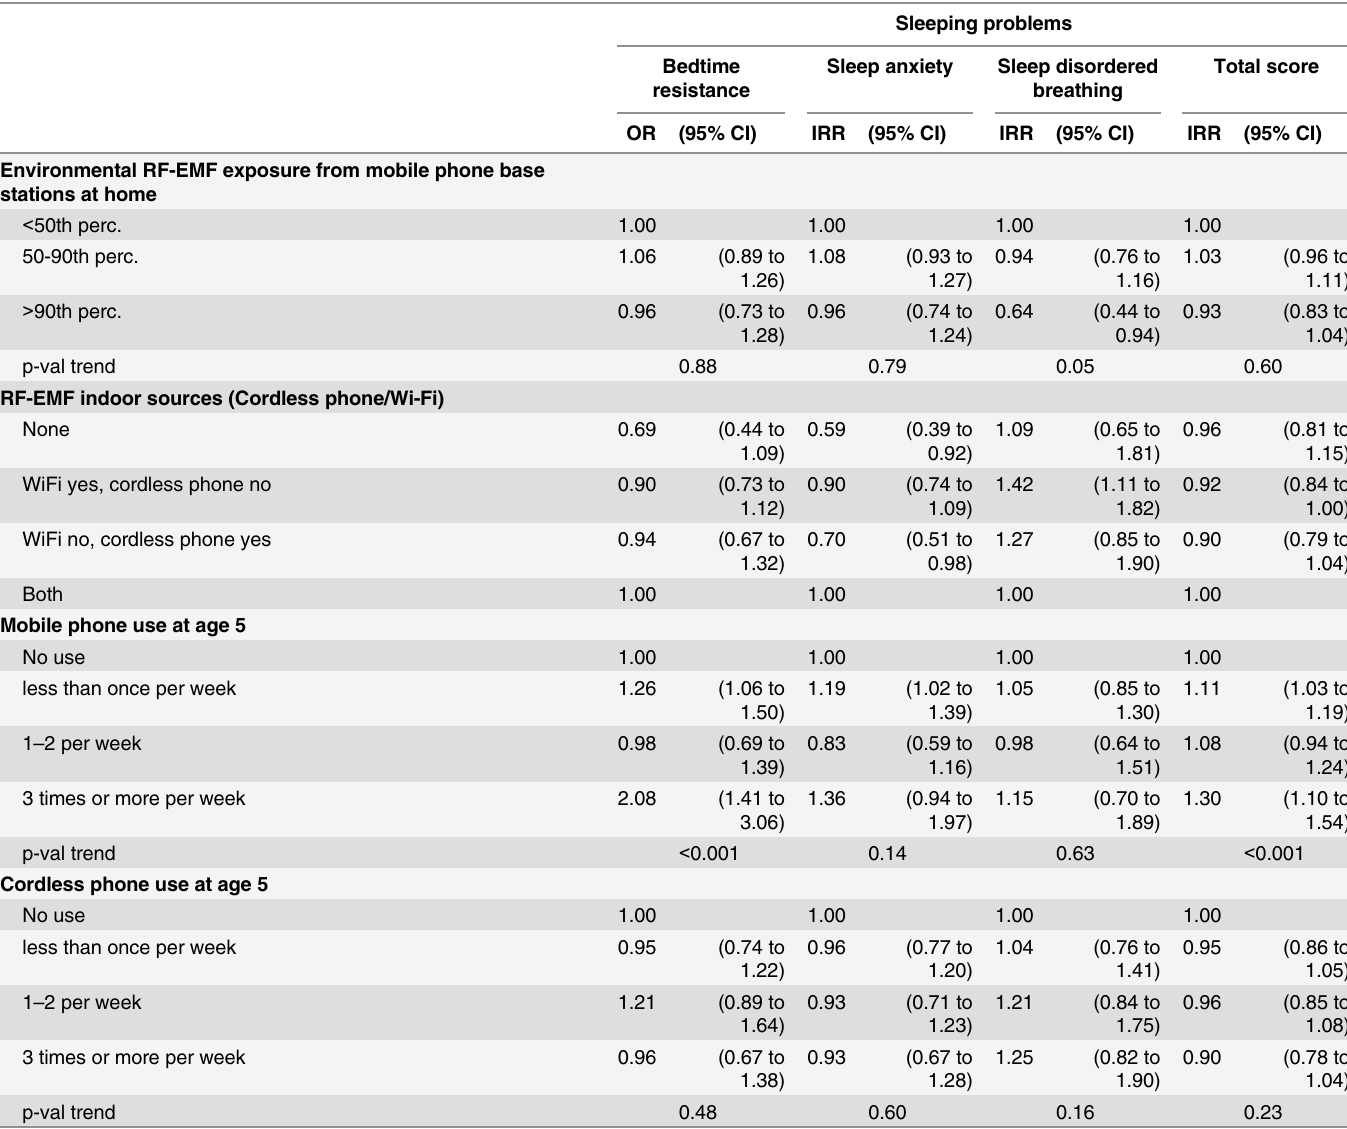
Table 5. Fully-adjusted association between RF-EMF exposure sources and those sleeping problems a priori hypothesized NOT to be potentially related to RF-EMF